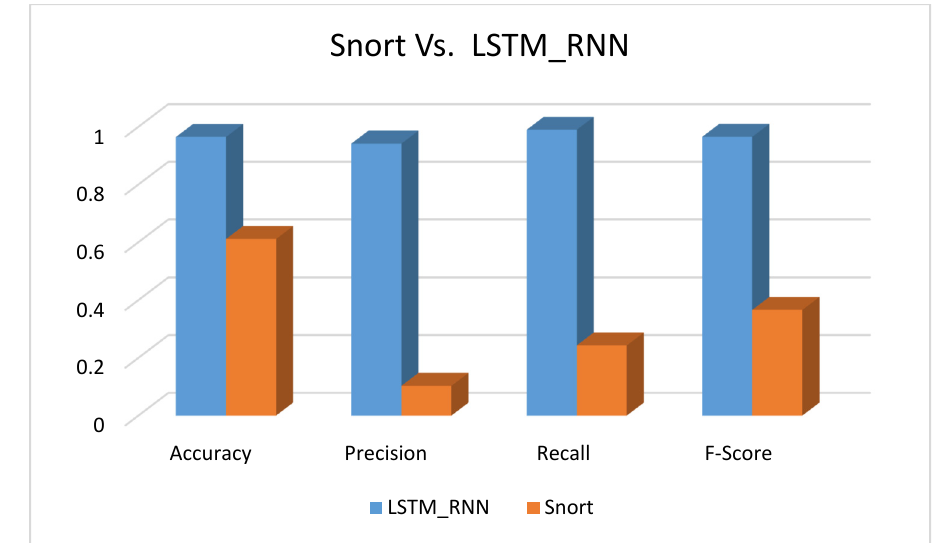
Figure 28. Signature-based performance Vs. LSTM_RNN.